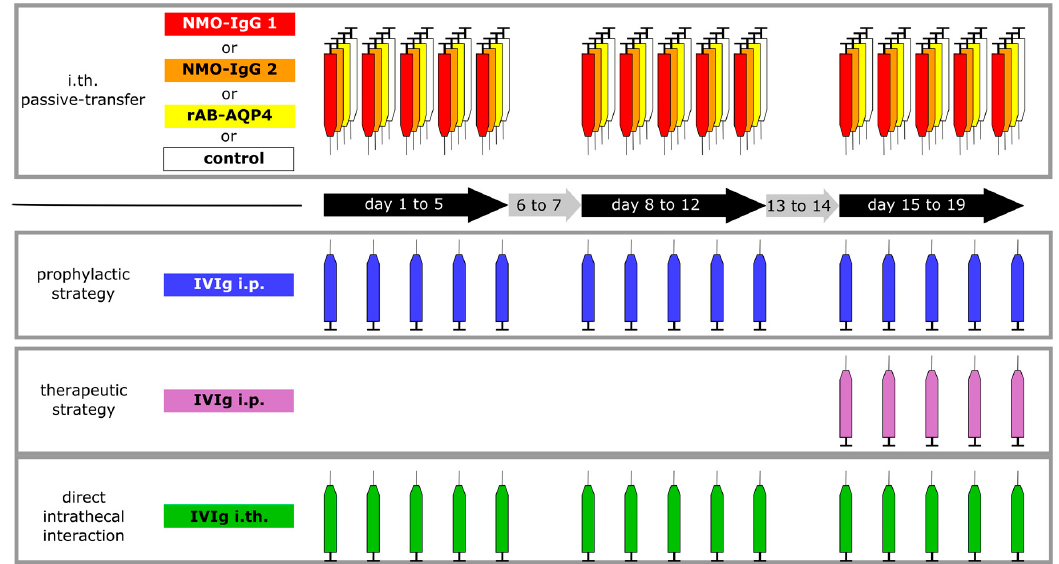
Figure 1. Schematic illustration of the study design. Repetitive intrathecal (i.th) application of purified patient IgG from two different patients (red and orange), recombinant human AQP4-ABs (rAB-AQP4, yellow), or control IgG (white), were performed in 3 series of five daily applications and 2 two-day breaks in between (3 weeks injection period in total). In a preventive, systemic strategy, pooled human immunoglobulin (IVIg) was applied intraperitoneally (i.p., blue). To test the therapeutic effect of IVIg in our model, IVIg was applied systemically only during the third series of i.th. passive transfer (purple). In a third approach, testing for direct antagonizing effects, IVIg was co-administered